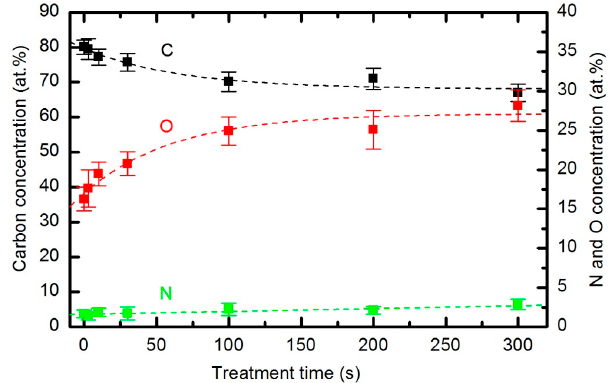
Figure 17. The composition of the surface film as calculated from the XPS survey spectra. The pressure was 33 Pa and the forward power was 150 W.